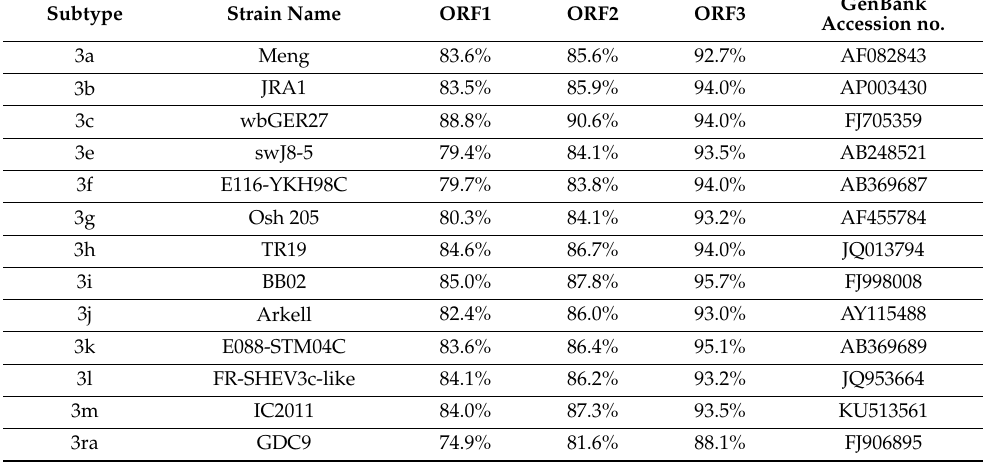
Table 1. Sequence identity of the HEV/81236/Wolf/2019/ITA (GenBank accession no. MZ463196) to prototype HEV strains representative of each Gt3 subtype for which the complete genome is currently